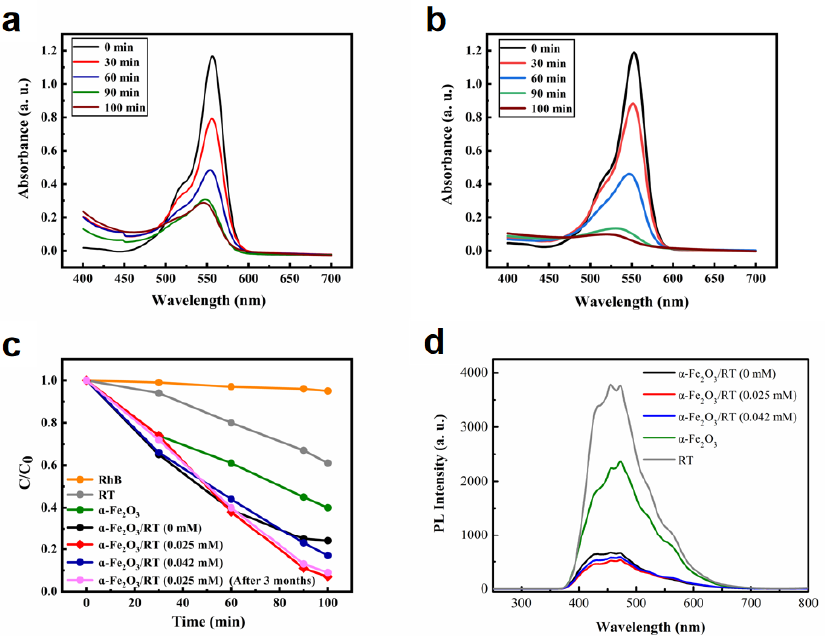
Figure 10. ( a ) Absorption spectra of the RhB solution containing α -Fe 2 O 3 /RT (0 mM), ( b ) absorption spectra of the RhB solution containing α -Fe 2 O 3 /RT (0.025 mM), and ( c ) photodegradation process of different catalysts towards RhB under visible light irradiation. ( d ) PL spectra for α -Fe 2 O 3 , RT, and α -Fe 2 O 3 /RT samples (0 mM, 0.025 mM, and 0.042 mM, respectively) measured at 200 nm.